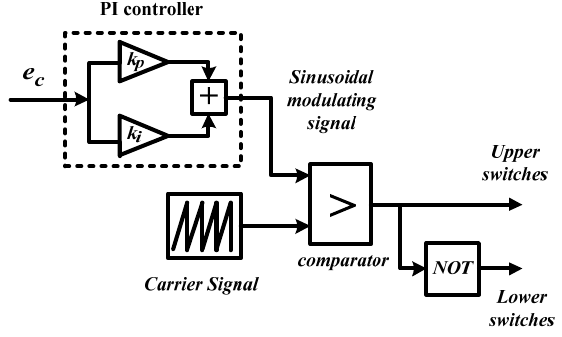
Figure 10. Conceptual model of a current control scheme with a PWM generator [41].